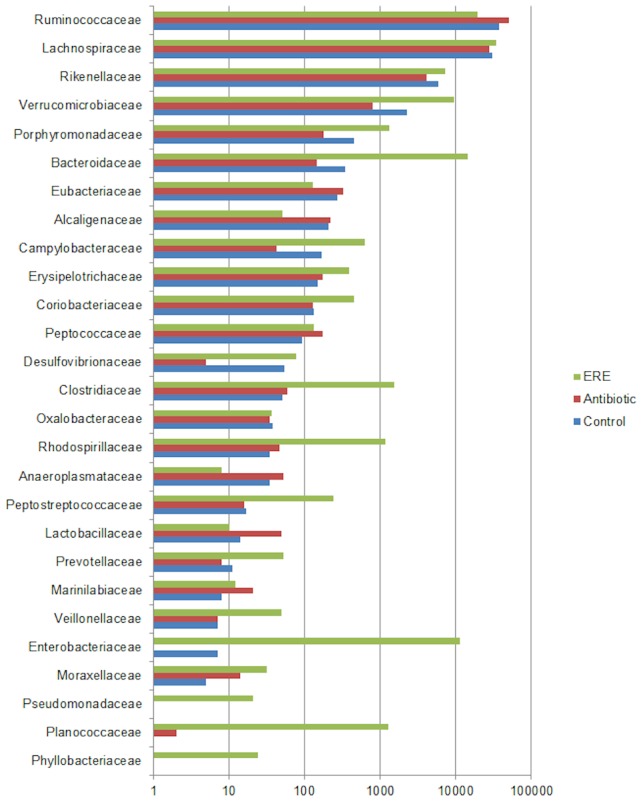
Total reads of bacterial families identified by SILVA after pyrosequencing of the 16S rRNA of the cecal content of rabbits.The graph represents the average for each of the three groups: control (white), antibiotic treatment (grey) and ERE (black).